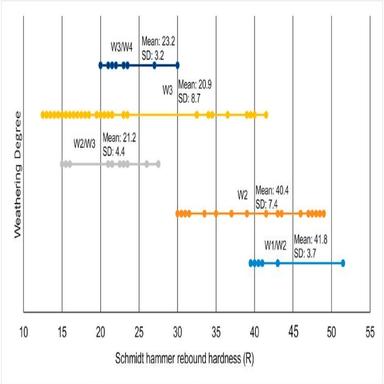
R values from the Schmidt hammer for different weathering classes performed perpendicular to the foliation.